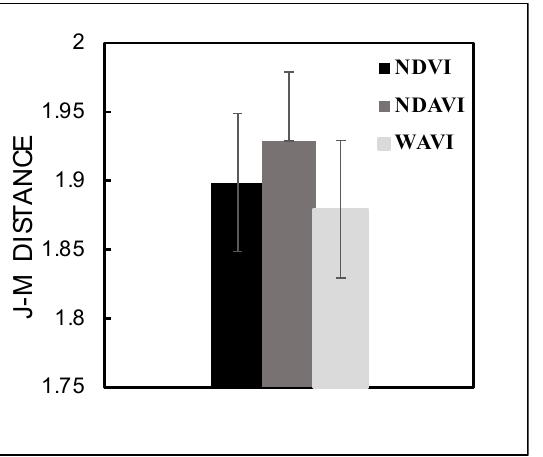
Figure 2. Target classes separability values (Mean ± SD) obtained from three different vegetation indices over selected Region of Interest for each class.